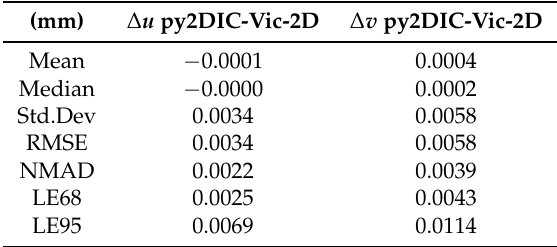
Table 7. Comparison with Vic-2D : statistical parameters of displacement differences.